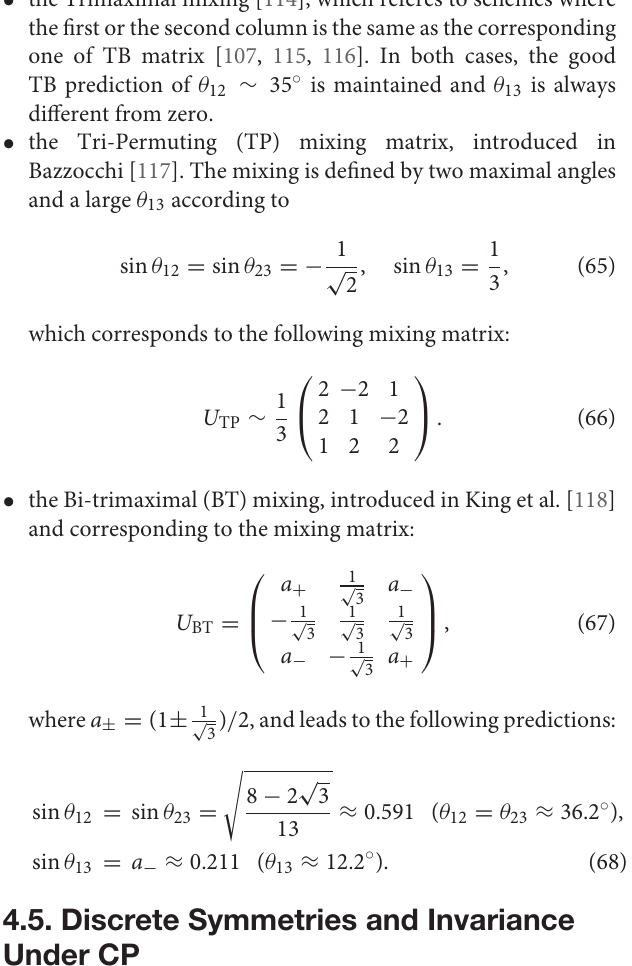
TABLE 3 | Possible independent algebras of S 4 subgroups (same classification as the one adopted in de Adelhart Toorop et al. [111]). Z 4 Z 3 V Algebra Generators Algebra Generators Algebra